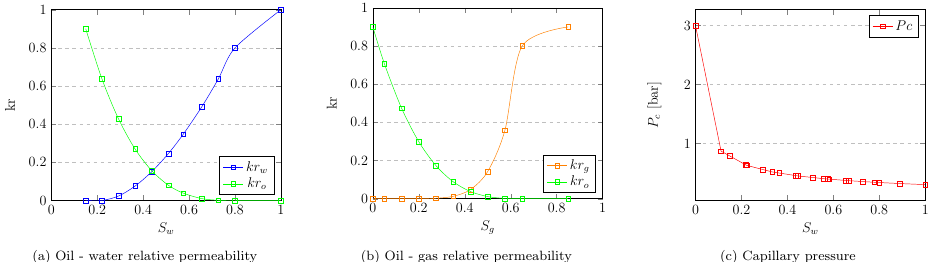
Fig. 15: Fluid - rock interaction function. Source: AGH UST Drilling Oil and Gas Fac- Figure 15. Fluid-rock interaction function. Source: AGH UST Drilling, Oil and Gas Faculty synthetic ulty synthetic benchmark model, based on data from internal investigation of fluid-rock benchmark model, based on data from the internal investigation of fluid-rock interaction in the interaction in Carpathian fields. Carpathian fields.